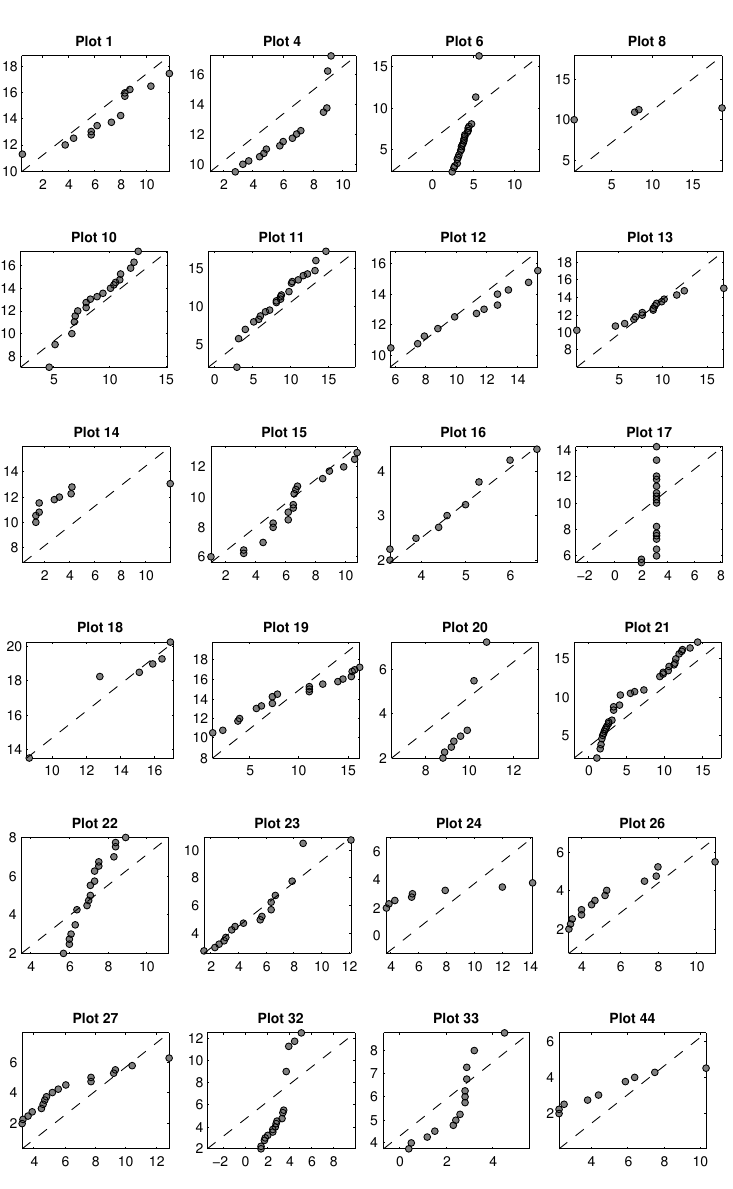
Figure 8. Correlation between calculated gap heights (y-axis) and field-measured CBH values (x-axis) for individual trees in 24 sample